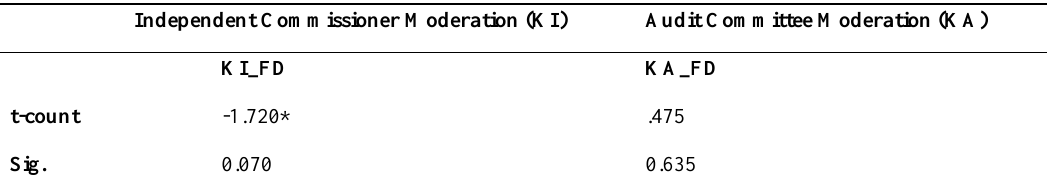
Table 4: Residual Analysis of Moderation